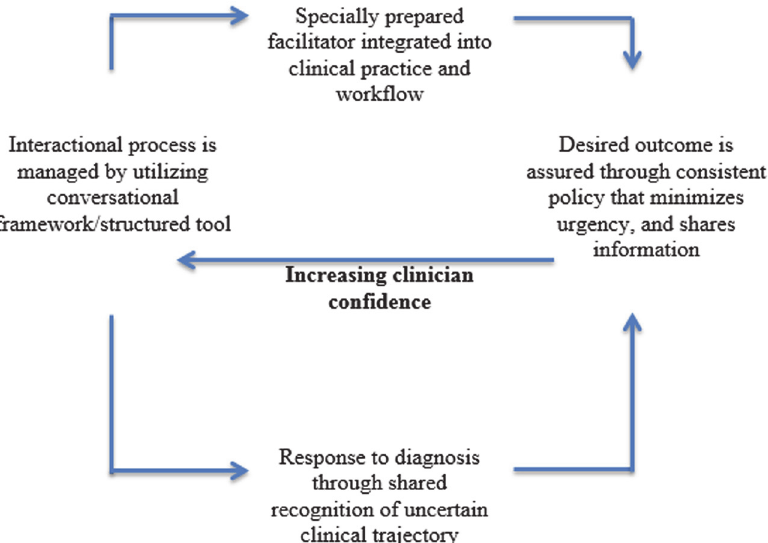
Fig 2. Operationalizing Advance Care Plans: Facilitators.